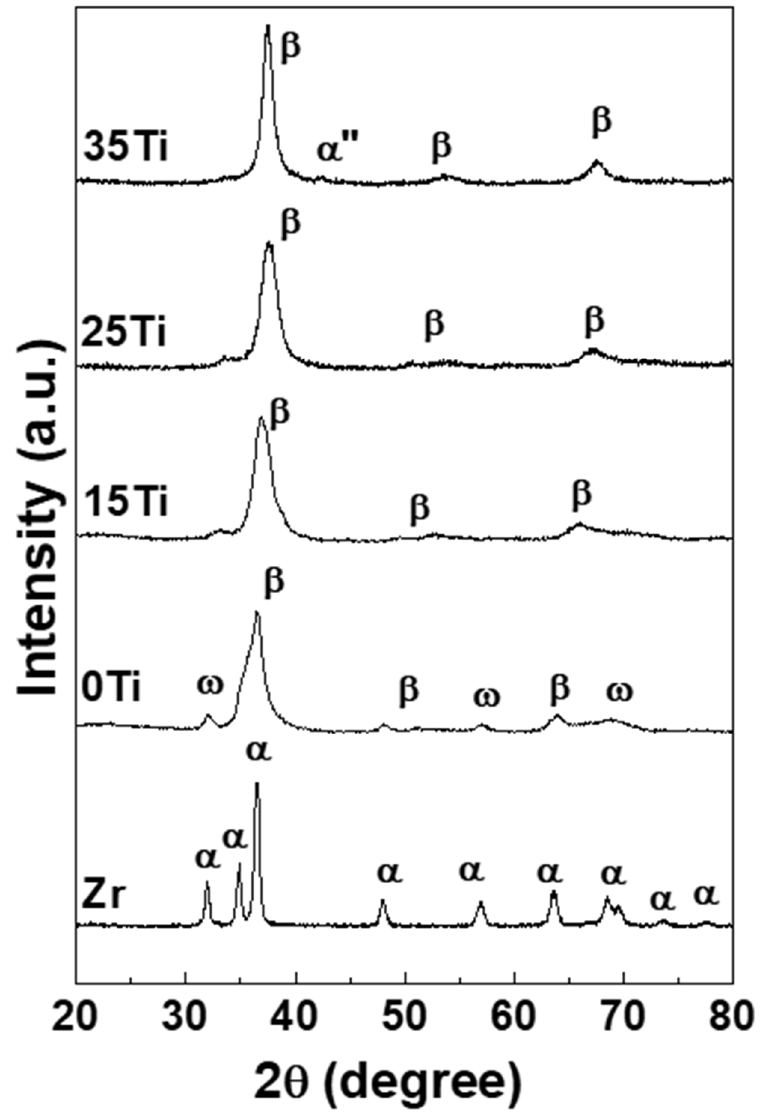
Figure 3. X-ray diffraction patterns for zirconium; Zr-25Ta-0Ti alloy, Zr-25Ta-15Ti alloy; Zr-25Ta-25Ti alloy, and Zr-25Ta-35Ti alloy.